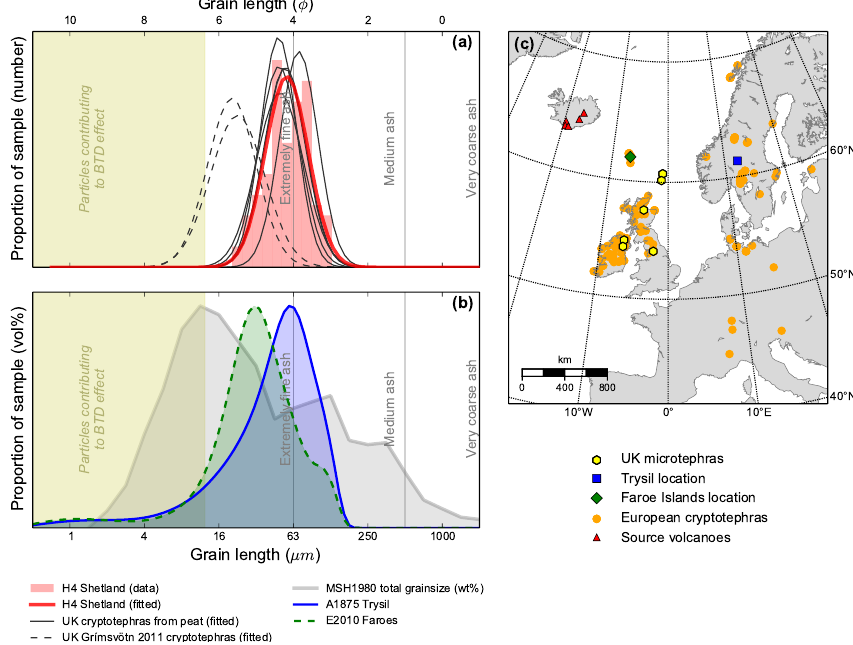
Figure 2. Deposition of Icelandic ash in Europe. (a) Long-axis number distributions of UK cryptotephra. The example histogram and red fitted curve represent the Hekla 4 eruption collected in Shetland, Scotland. The fitted curves (lognormal distribution) of UK cryptotephra ex- tracted from peat or collected during the Grímsvötn 2011 eruption are also plotted. Grain sizes measured in φ units, where φ = − log 2 (d mm) are used in volcanology and sedimentology. (b) Particle size distributions measured by laser particle size analysis. Particles <12µm are present only as a minor component and the modal grain sizes are similar to (a) . The total deposit grain-size distribution of the 1980 Mount St Helens eruption is plotted for comparison (Carey and Sigurdsson, 1982). (c) Map of sample locations and source volcanoes. Other European cryptotephra is plotted for context (Lawson et al., 2012; Lane et al., 2012; Bramham-Law et al., 2013; Housley et al., 2013). Limitations of identification methods imply that they have a minimum grain size of ∼